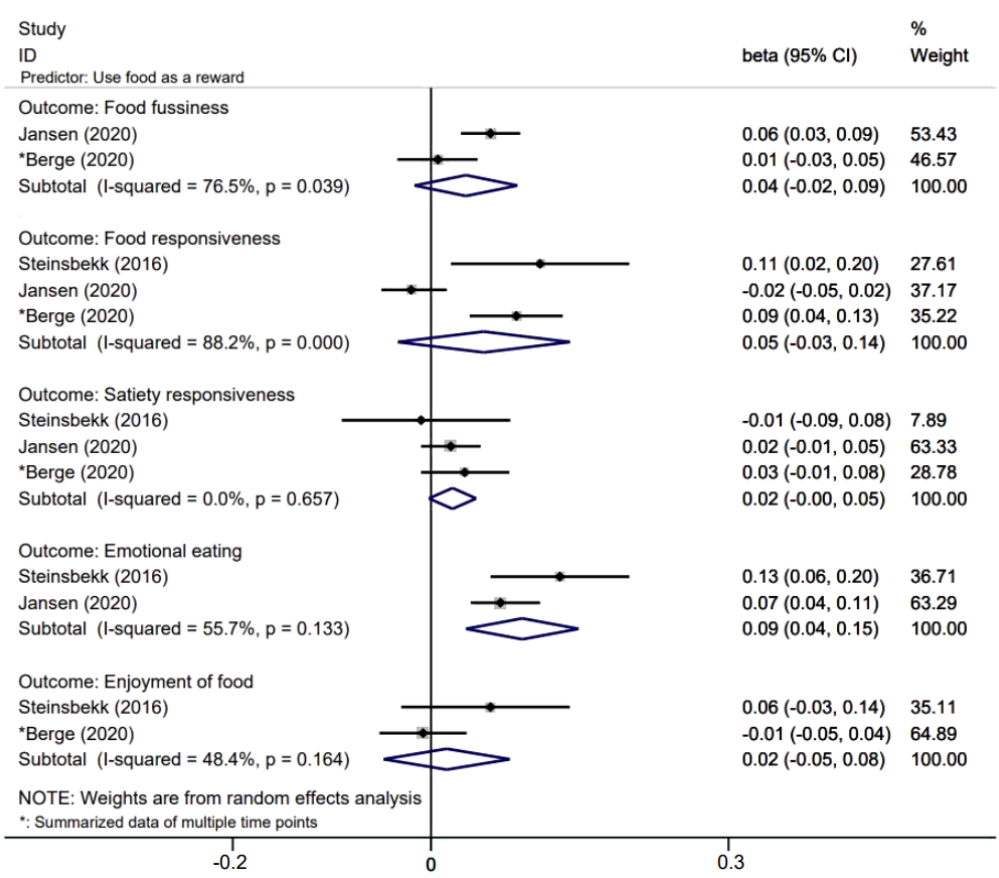
Figure 4. Effects of parental use of food as a reward on child eating behaviors.